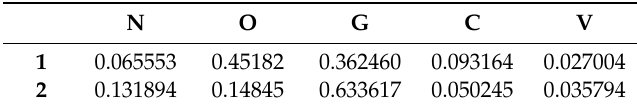
Table 3. The emission probabilities between the two hidden states, 1 and 2, and the five observations, N, O, G, C, V. N